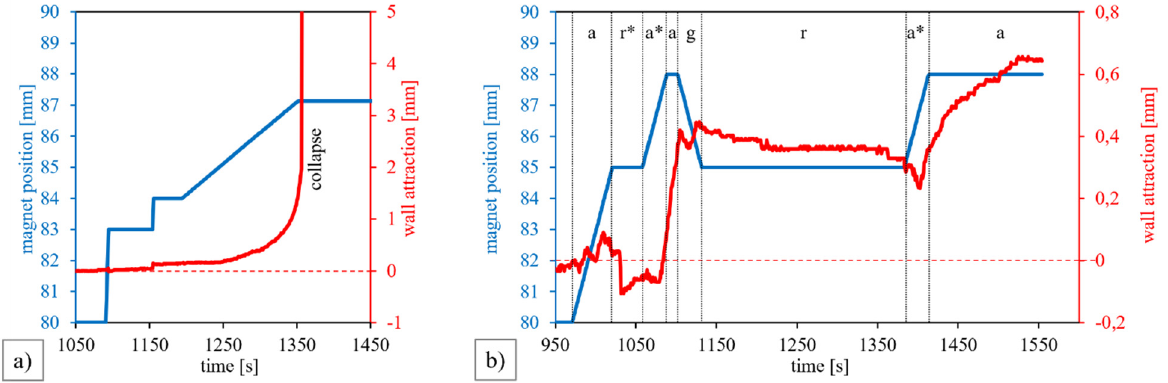
Figure 13. Recorded measurement results with laser sensor: ( a ) stepwise approach of the magnet position until wall collapse; ( b ) improved wall deformation with decreasing wall attraction velocity and relaxation. a—approach, r—relaxation, * groove scattering.